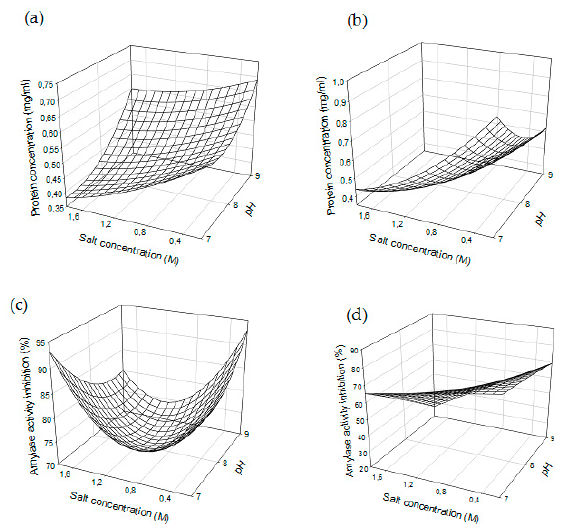
Figure 2. Response surfaces of ( a , b ) protein concentration and ( c , d ) amylase activity inhibition as function of salt concentration and pH with Julius and Poncticus , respectively. Extraction time is fixed at central point (105 min).